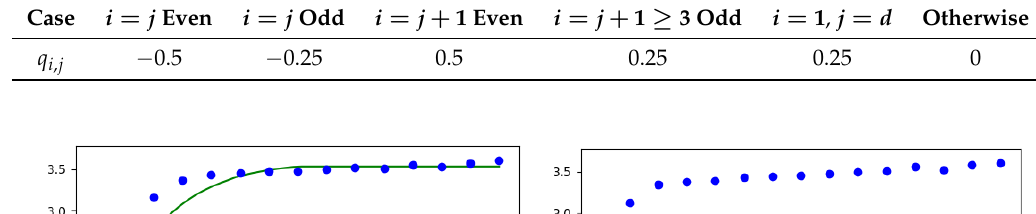
Table 4. Intensity matrix values for the dividend problem.